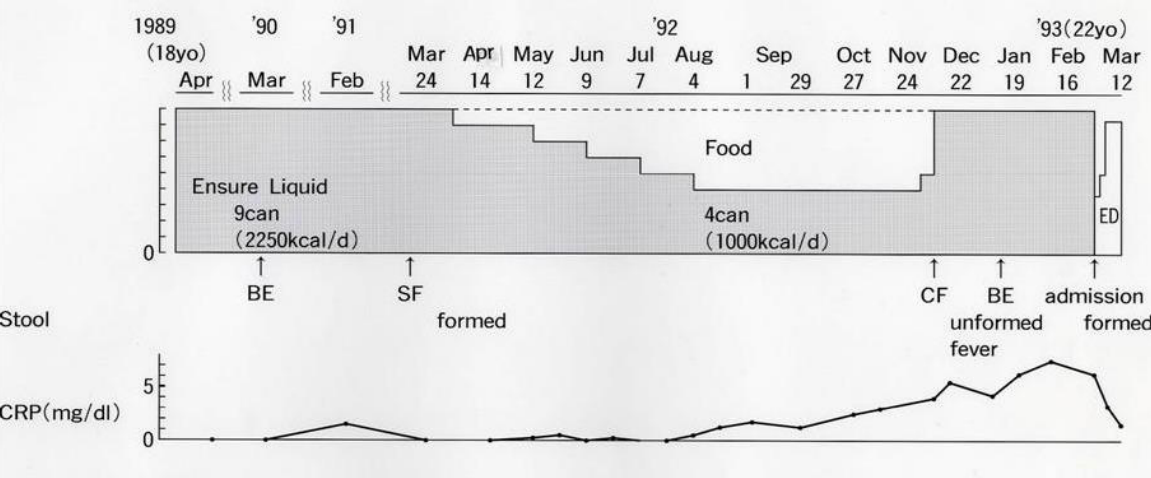
Figure 2. An attempt to gradually replace Ensure Liquid (polymeric enteral nutrition) with ordinary food in a male student with Crohn’s disease. BE, barium enema; SF, sigmoido (fiber)scopy; CF, colono (fiber)scopy; ED, elemental diet; CRP, C- reactive protein (reference ≤0.3 mg/dL).